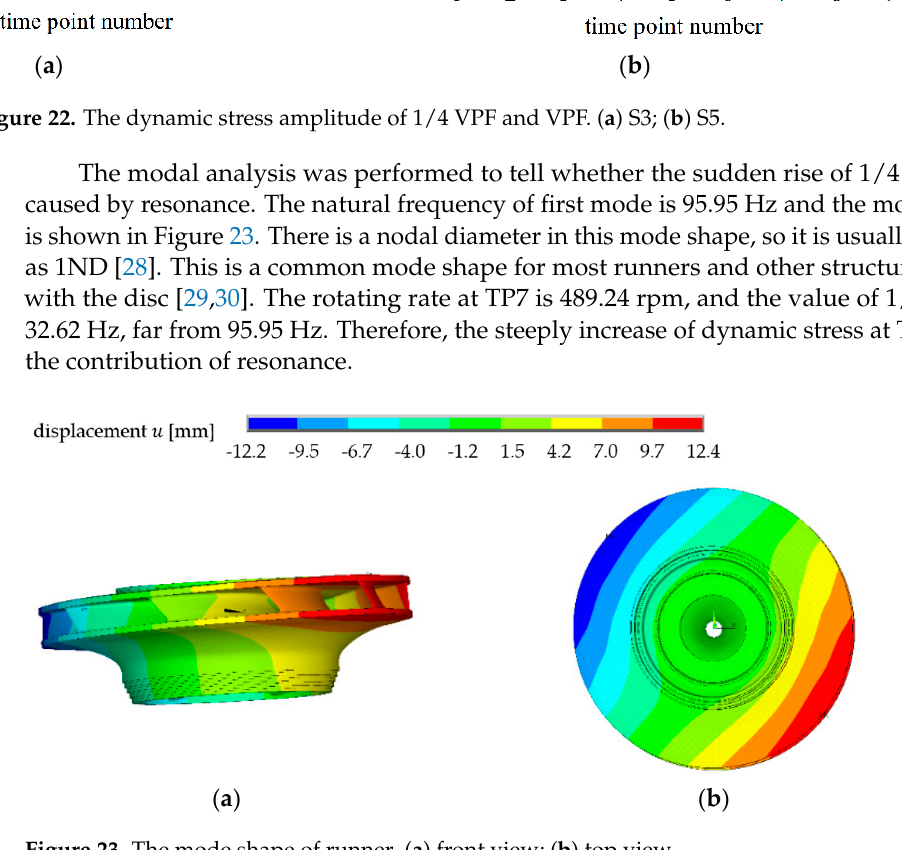
Figure 23. The mode shape of runner. ( a ) front view; ( b ) top view.